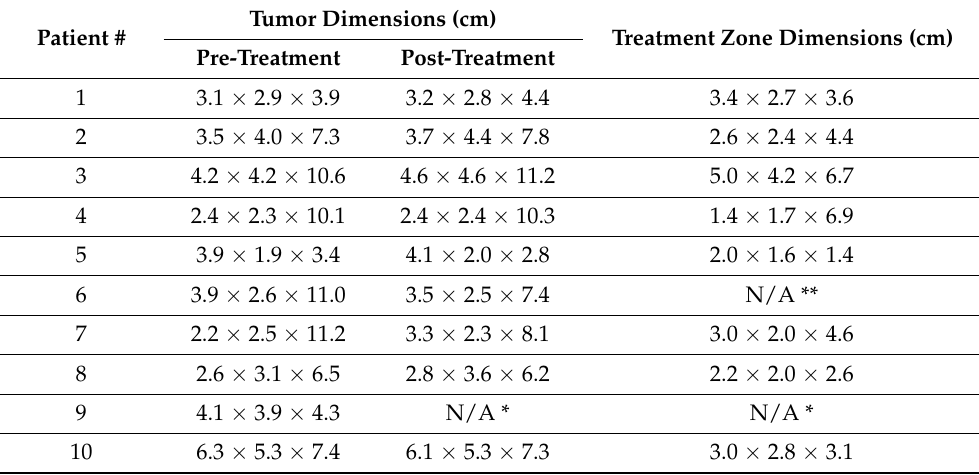
Table 3. Computed tomography-derived tumor dimensions pre- and post-histotripsy treatment and treatment zone dimensions post-histotripsy. * Post-treatment CT not collected due to scheduling constraints. ** Treatment zone not visible.